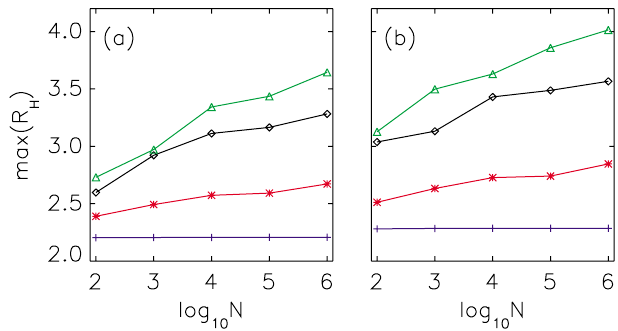
(cid:7) reached FIG. 3. (Color) Maximum halo amplitude max (cid:6) R H over a duration t (cid:2) 512 DE units versus the logarithm of the (cid:2) 0 and t (cid:2) 80 , and with test-particle population N with (cid:13) c 2 (cid:2) 0 : 05 , and (b) (cid:13) (cid:2) 0 : 1 . The four curves correspond to (a) (cid:13) 1 1 four different noise amplitudes. Blue curve with crosses: hj (cid:22)! ji (cid:2) 0 ; red curve with asterisks: hj (cid:22)! ji (cid:2) 0 : 001 ; black curve with diamonds: hj (cid:22)! ji (cid:2) 0 : 01 ; green curve with tri- angles: hj (cid:22)! ji (cid:2) 0 : 1 .